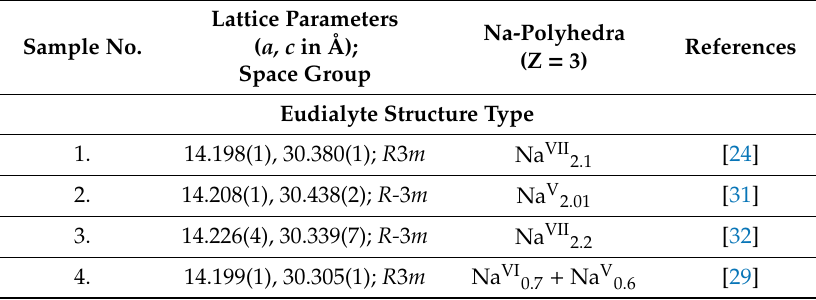
Table 4. EGMs containing Na at the M 2